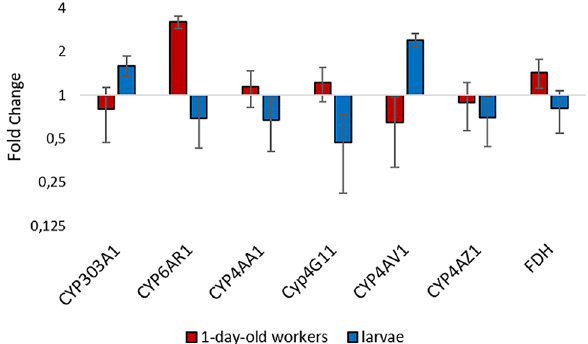
Figure 7. Fold change expression of the candidate genes equally tested between workers (red) and larvae (blue) in the RT-qPCR. Data are mean values ± SEM of the FA treated group (24 hpt). workers n = 60, larvae n =